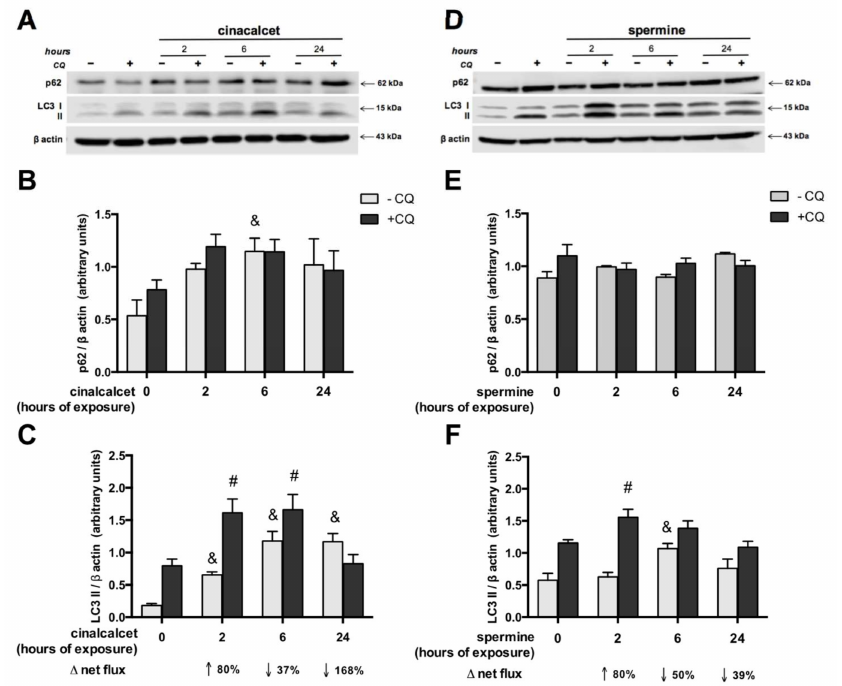
Figure 3. Autophagy flux is modulated by cinacalcet or spermine in human adipose tissue explants. LC3II and p62 protein expression was determined after 2, 6 and 24 h of ( A – C ) 2 µ M cinacalcet or ( D – F ) 100 µ M spermine with or without chloroquine (CQ) to determine the protein levels under autophagy flux inhibition or basal conditions, respectively. LC3 and p62 abundance was normalized by β -actin. Di ff erences between vehicle and treated conditions were determined by two-way ANOVA and Holm–Sidak’s multiple comparison post-hoc test. The symbols “&” ( − CQ) and “#” ( + CQ) represent p < 0.05 compared to the respective vehicle condition, n = 4–6 independent